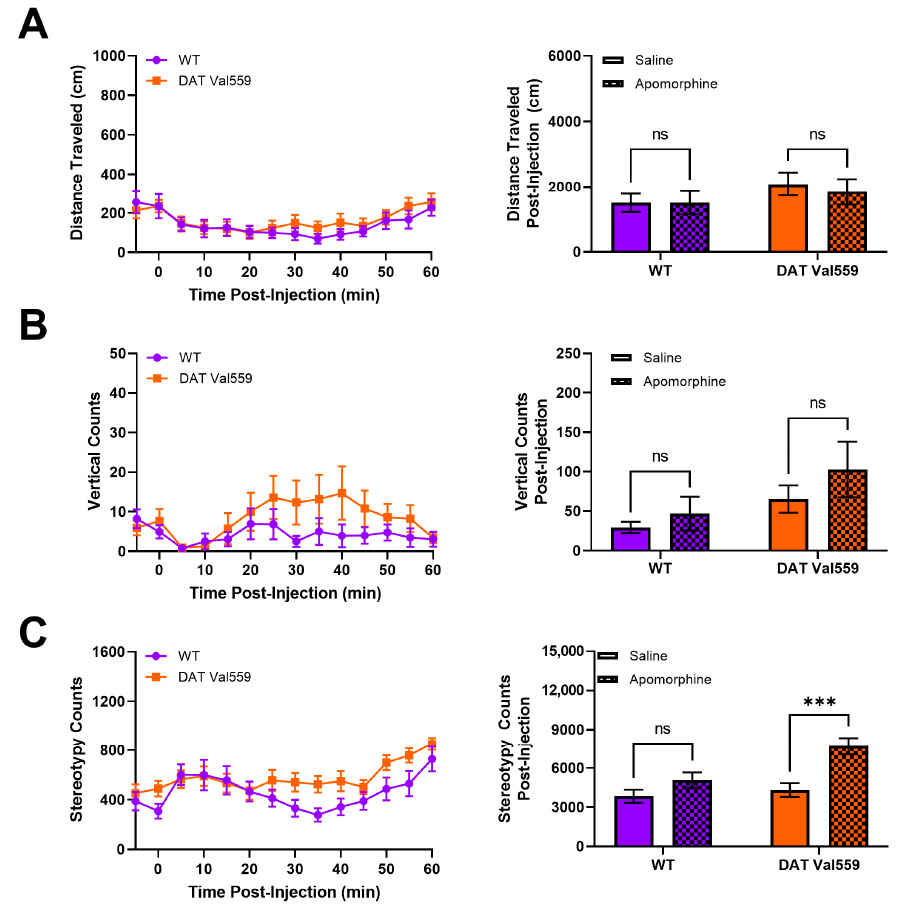
Figure 4. DAT Val559 males exhibit enhanced sensitivity to apomorphine-dependent repetitive motor movements. WT ( n = 13) and DAT Val559 ( n = 15) mice were given a single injection of the DA agonist apomorphine (5 mg/kg, s.c.) and locomotor activity recorded for 60 min post-injection. Datasets are presented in 5 min time bins across the recording period and as summary data adding up all activity post-injection. ( A ) Horizontal distance traveled. ( B ) Vertical locomotor activity. ( C ) Stereotypic motor movements. Data were analyzed by two-way ANOVA with Sidak’s multiple comparison’s test. *** p < 0.001. ns = not significant. Data are presented as mean ± SEM.